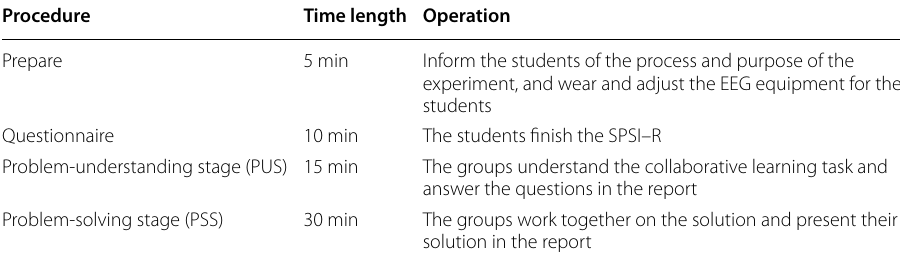
Table 2 Procedures of the CPS activity